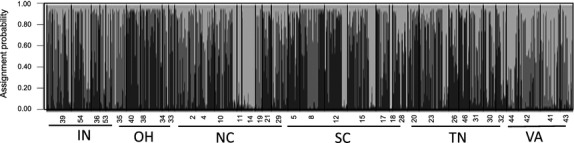
STRUCTURE assignment of individuals to genetic clusters. Small bars represent the assignment of individuals to clusters, with sampling locations differentiated by thick black lines for 35 populations sampled. Shown are each population denoted by State: IN = Indiana, OH = Ohio, NC = North Carolina, SC = South Carolina, TN = Tennessee, VA = Virginia, and population ID number.